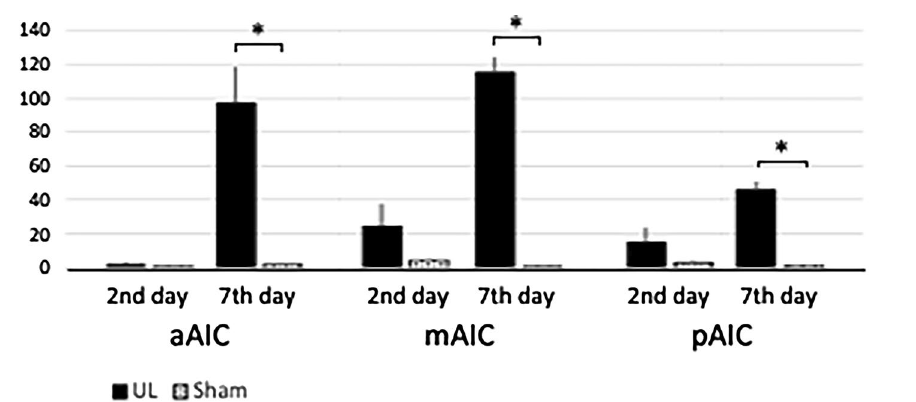
Figure 12. Activated neurons in mPFC. There were significantly more activated neurons in the mPC, dAC, and PL on both day 2 and day 7 after UL, but not in the IL. Error bars indicate the standard error of the mean.